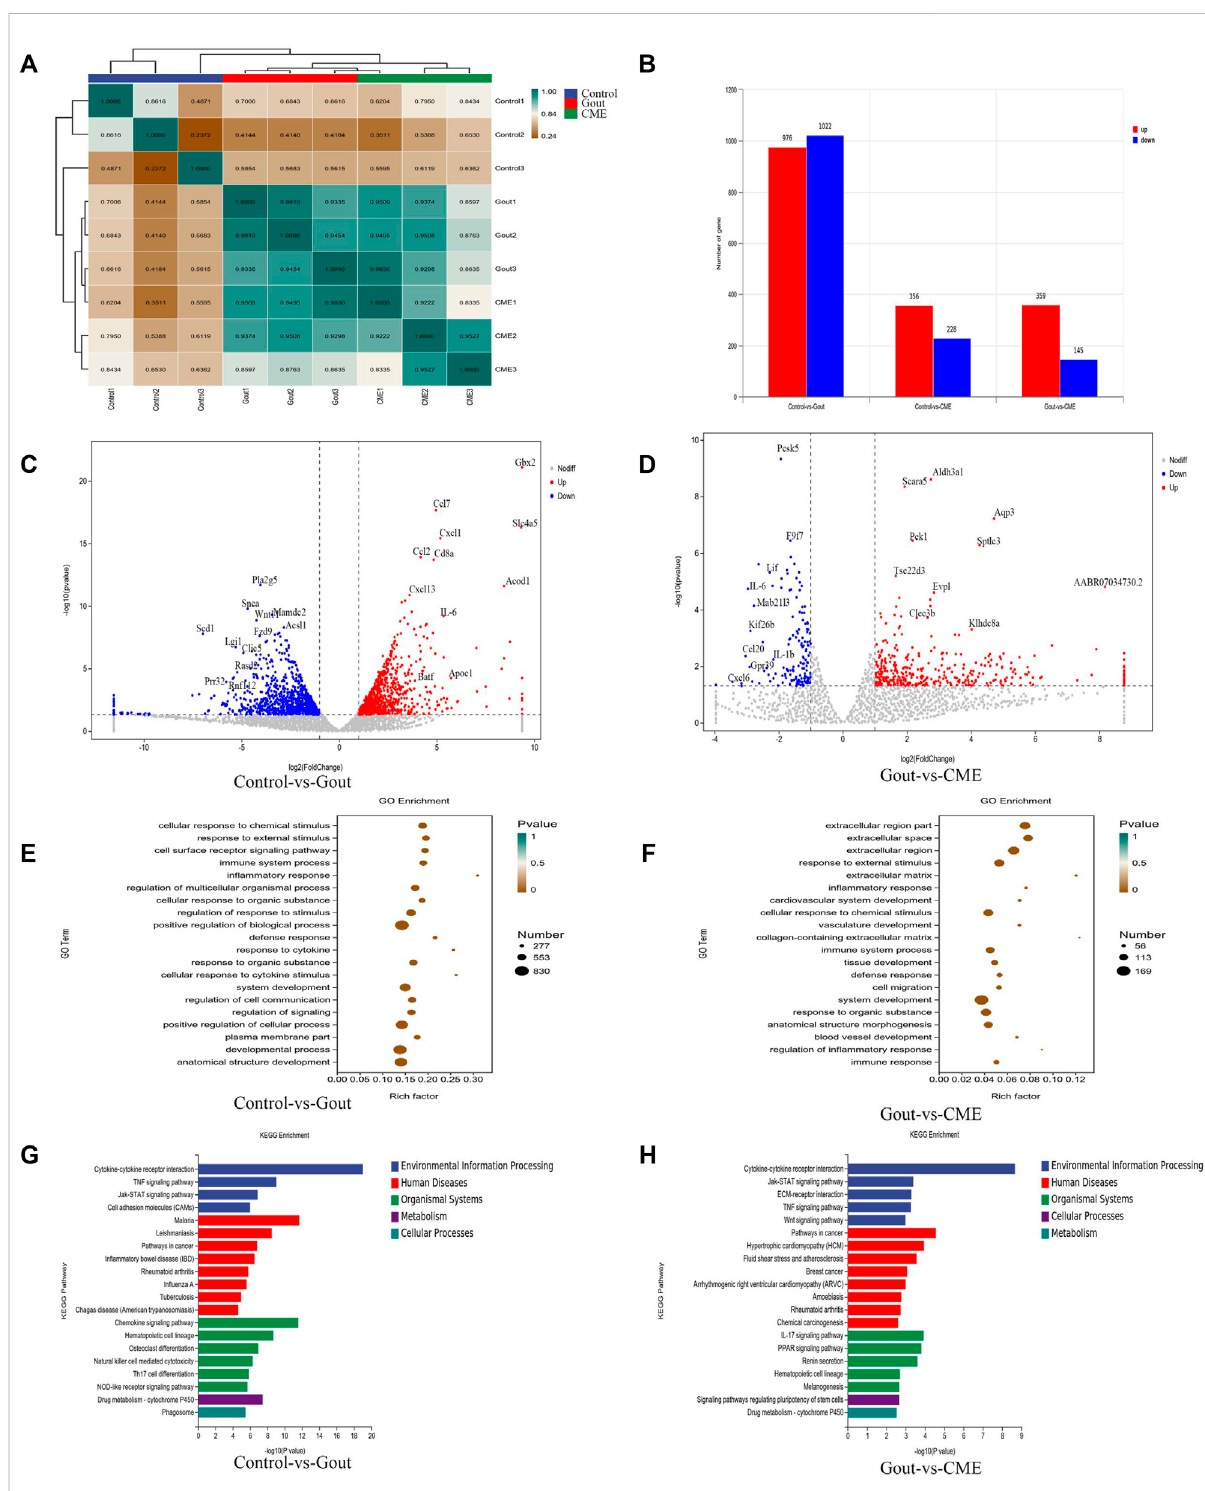
FIGURE 3 Effects of CME on the transcriptomic pro fi le of MSU-induced acute gout. (A) Correlation heat map of differential genes between groups (B) Statistics of differential expression results (C) Volcano plot of differential genes between control and gout groups ( n = 3/group) (D) Volcano plot of differential genes between CME and gout groups ( n = 3/group) (E) Control and gout groups GO enrichment analysis (F) GO enrichment analysis of CME and gout group (G) KEGG enrichment analysis of control and gout group (H) KEGG enrichment analysis of CME and gout